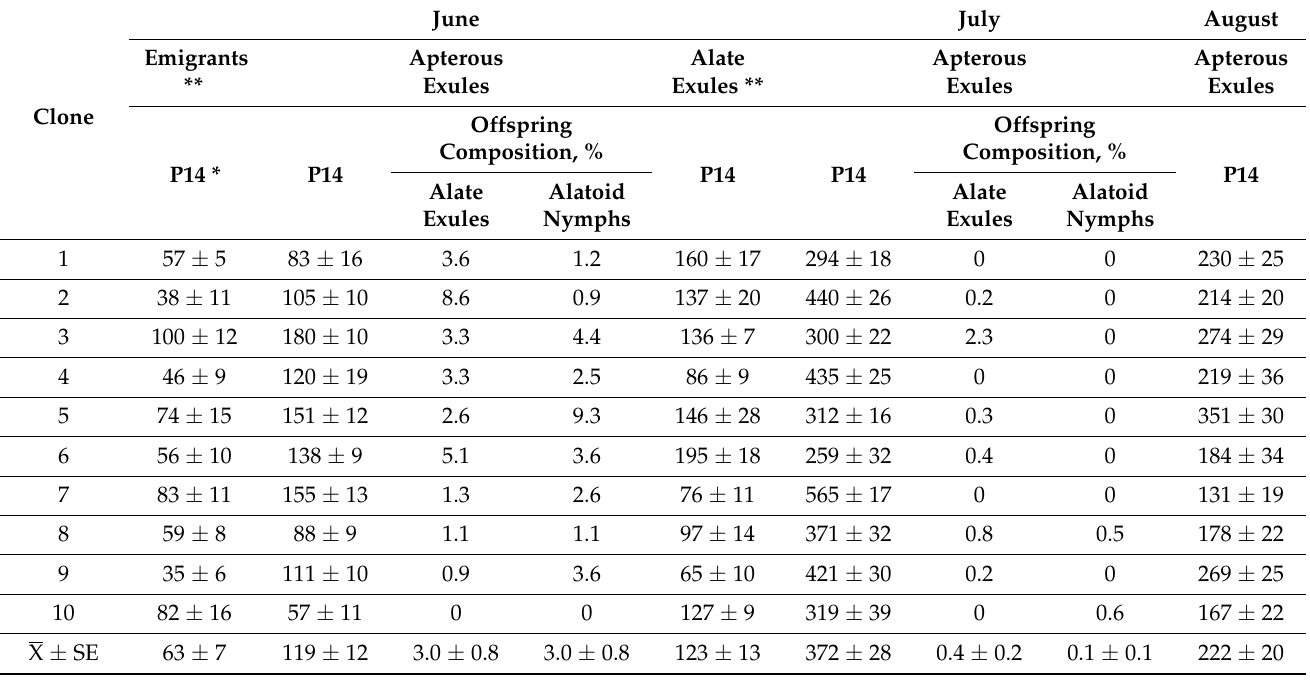
Table 2. The number and composition of summer morphotypes offspring of various clones and generations of Metopolophium dirhodum (Walk.) in 2020.